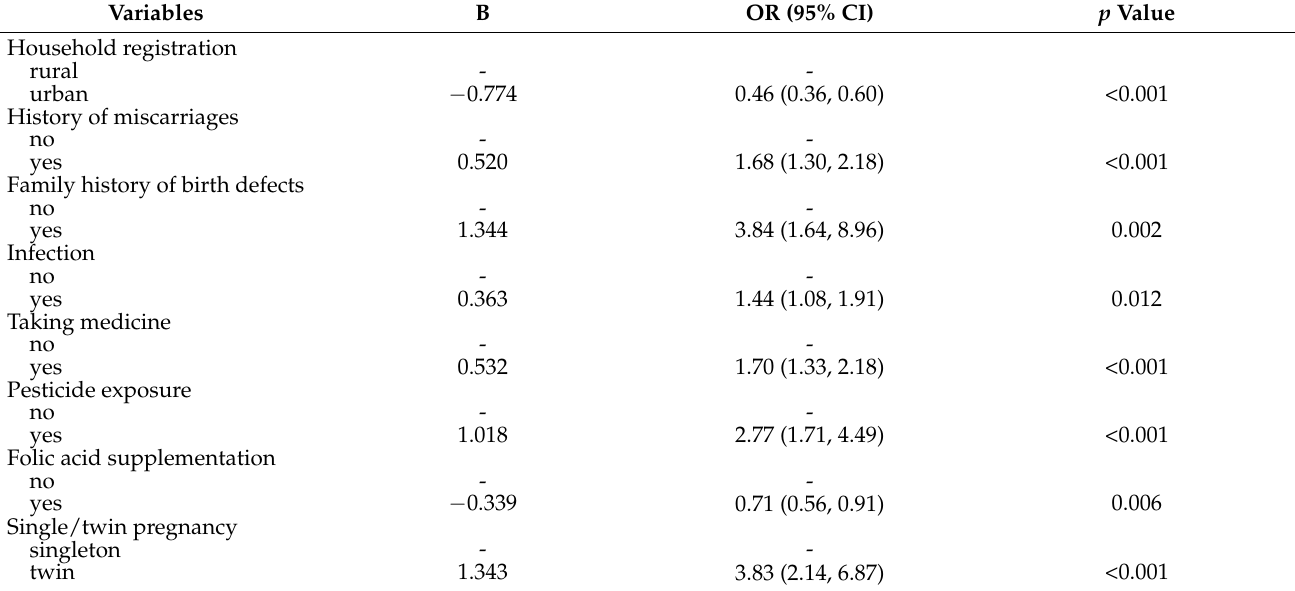
Table 3. Multivariate logistic analysis of factors predicting birth defects in the training group.